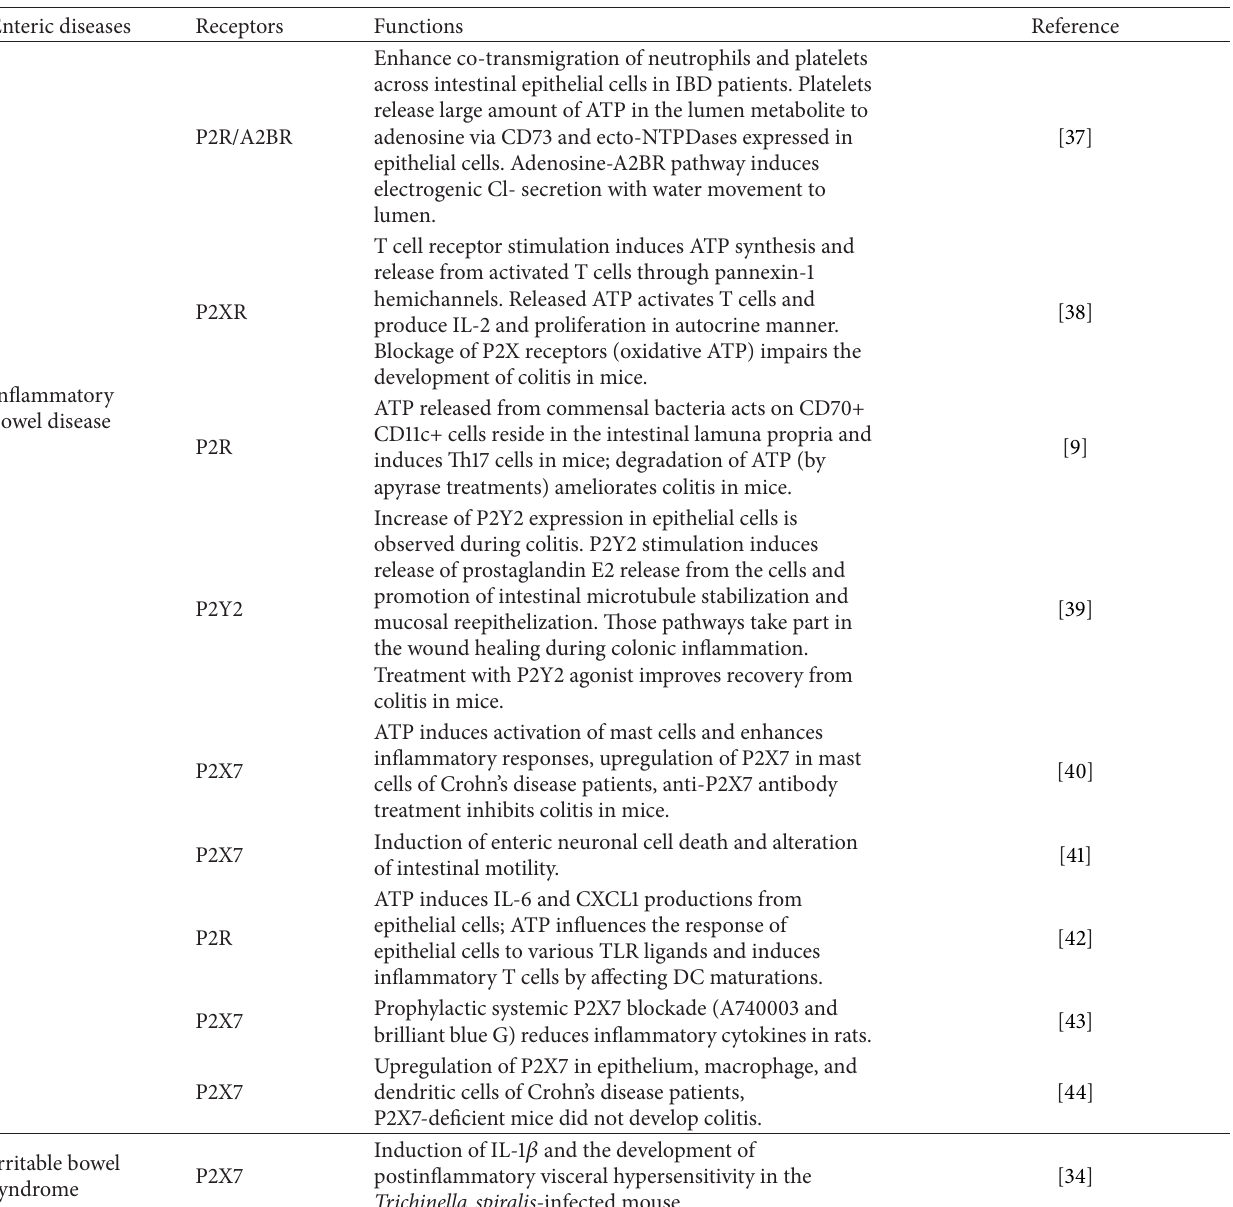
Table 1: Recent reports indicating the critical roles of eATP in the adverse conditions of intestines (inflammatory bowel diseases and irritable bowel